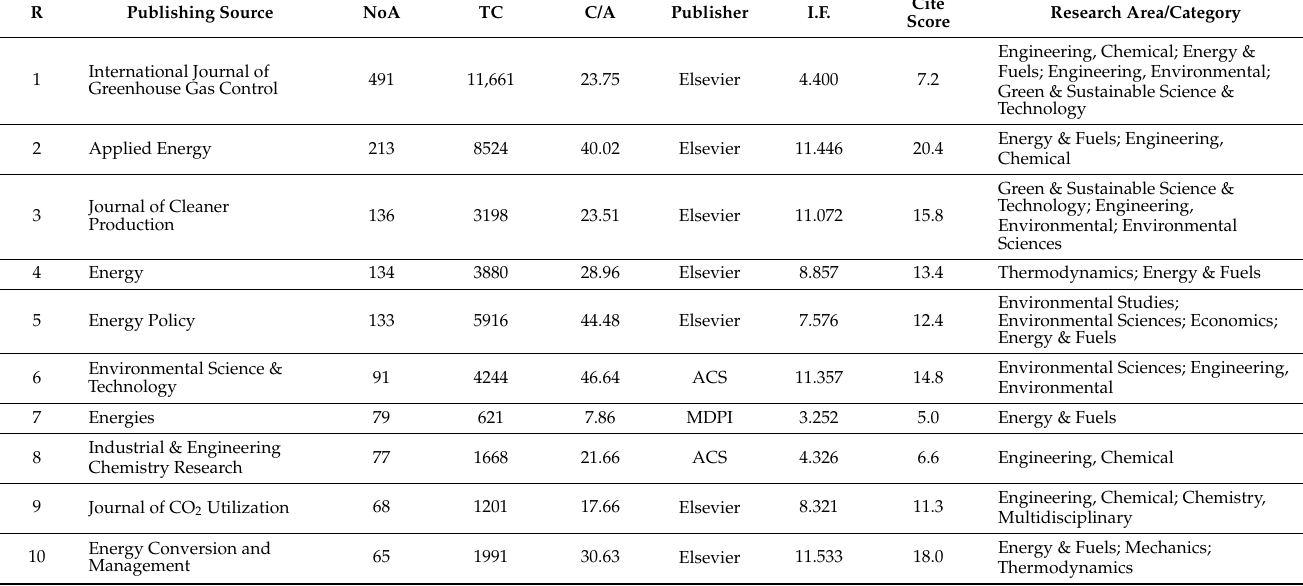
Table 8. Top ten sources publishing research on carbon capture and utilization (based on number of total